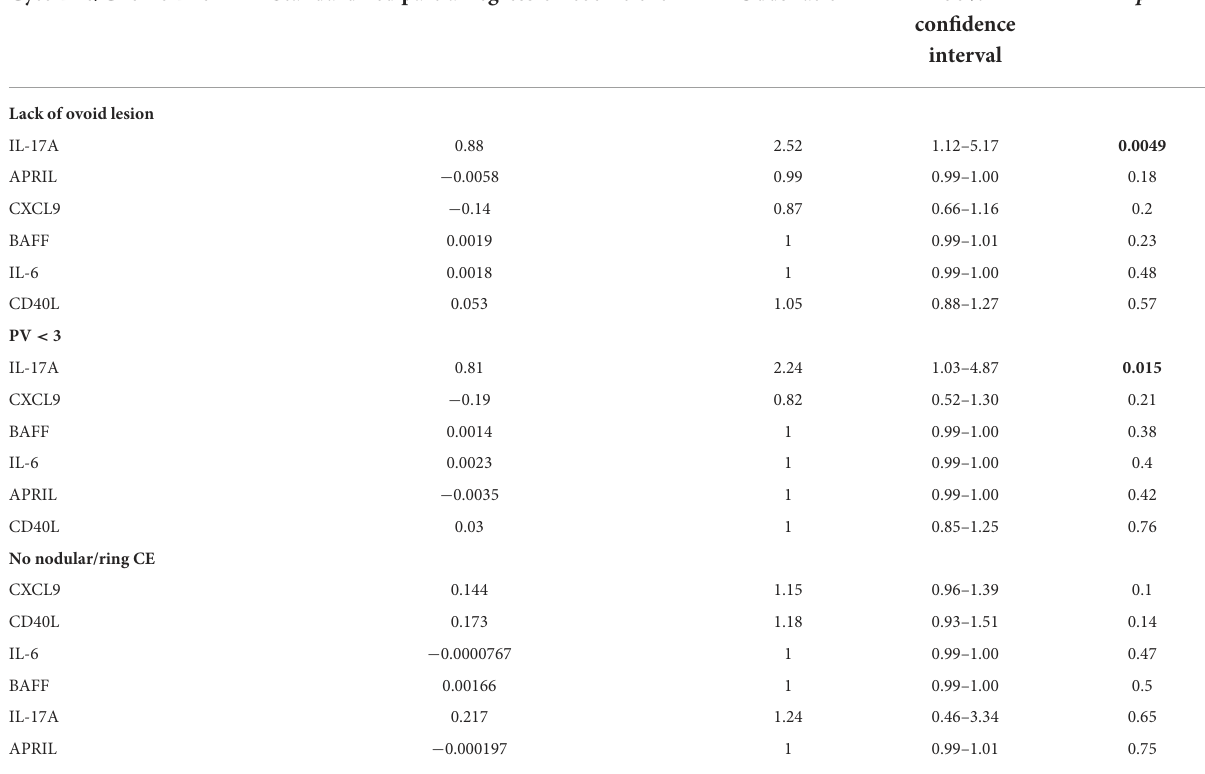
TABLE 2 Multivariate analysis of radiological findings among MS patients using cytokine/chemokine levels in CSF. Cytokine/Chemokine Standardized partial regression coefficient Odds ratio 95%